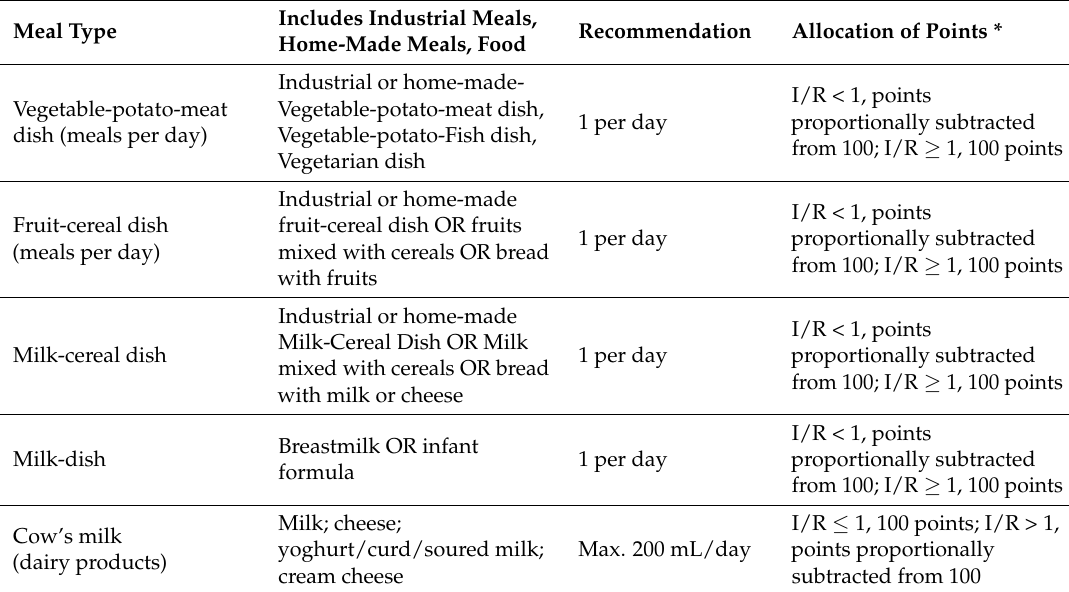
Table A1. Calculation of the SOCCER